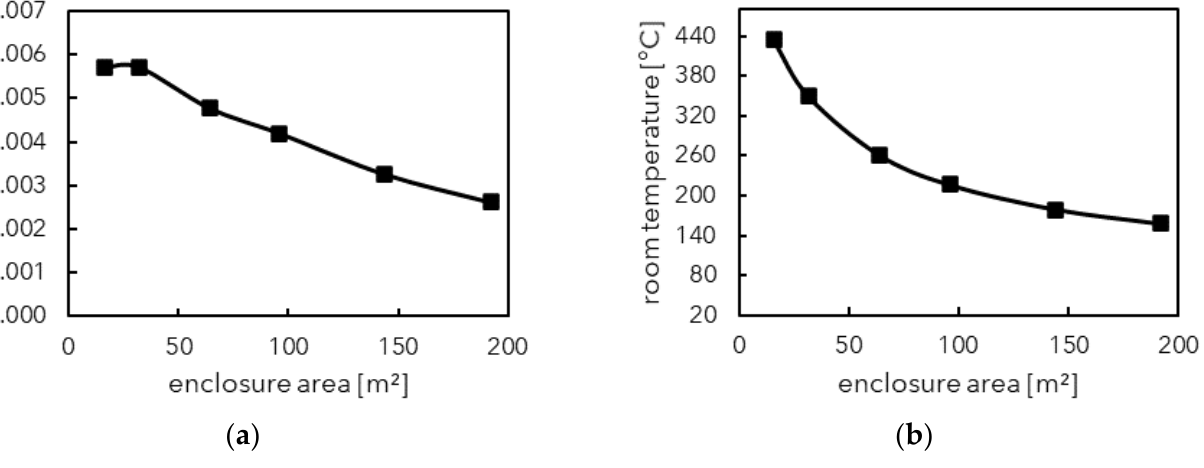
Figure 6. Comparison of results for enclosure area sensitivity study, measured in the full apartment volume at t = 460 s: ( a ) mean soot mass fraction; and ( b ) mean temperature.